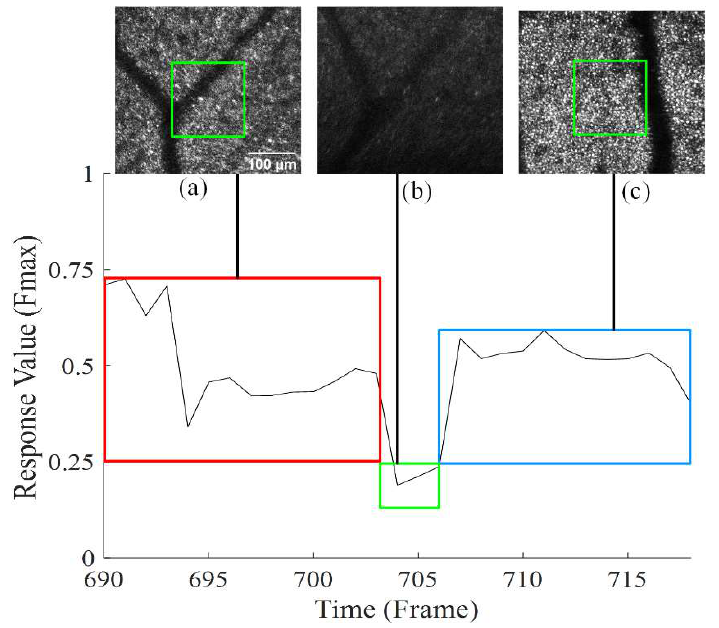
F ; ( a , c ) are the references of the two sequences (the red and blue Figure 4. The response value Figure 4. The response value F max ; ( a , c ) are the references of the two sequences (the red and blue max F  0.25) and ( b ) indicates the reference lost (the boxes represent that the reference is not lost, boxes represent that the reference is not lost, F max ≥ 0.25) and ( b ) indicates the reference lost (the max F  0.25). The scale bar is 100 µm. The green boxes green box represents that the reference is lost, green box represents that the reference is lost, F max < 0.25). The scale bar is 100 µ m. The green boxes max in ( a , c ) are the UECO in ( a ) and ( c ) are the UECO reference.